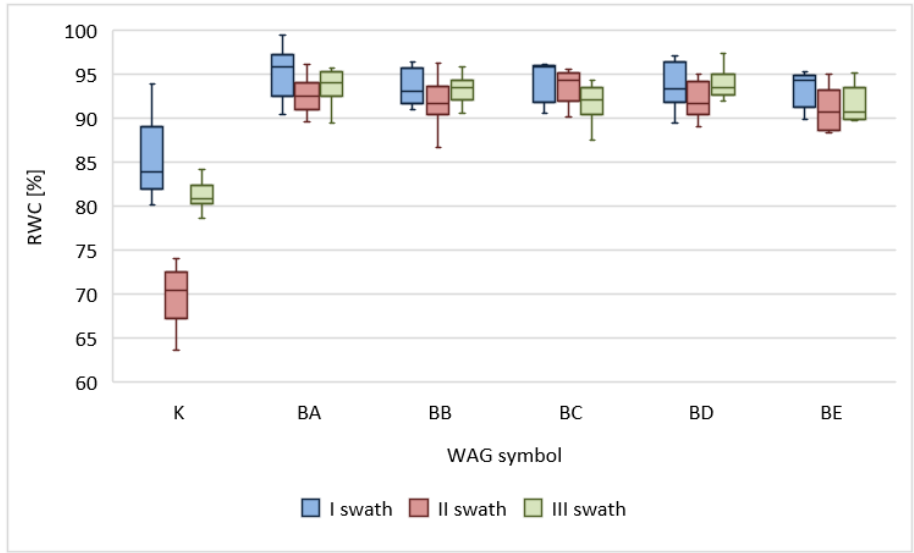
Figure 5. The influence of WAGs on relative water content (RWC). The diagram shows the first and third quartiles, medians, and minimum and maximum